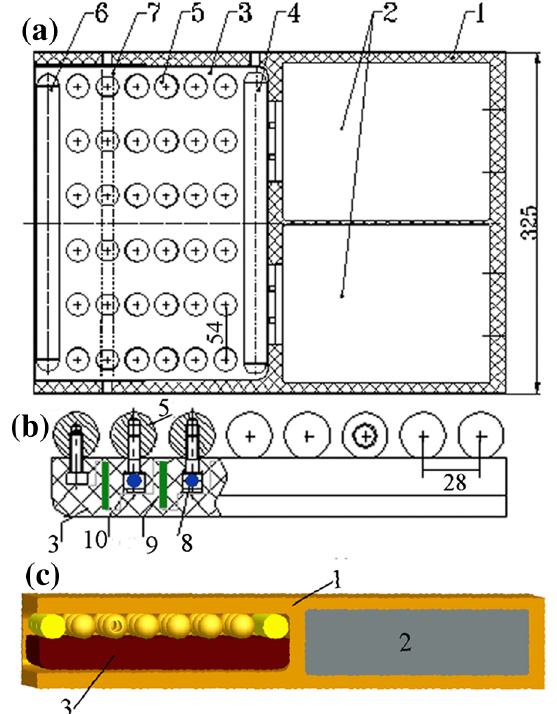
FIG. 2. (a) Cross-section drawing of the capacitor block, (b) electrode system assembly, (c) 3D model cut view. Here shown: 1—epoxy body; 2—capacitors GA 35426; 3—switch plate; 4—HV electrode; 5—ball switch electrodes; 6—low voltage electrode; 7—triggering cable; 8—conductive cord; 9—divider resistors; 10—special screws for the balls mounting.